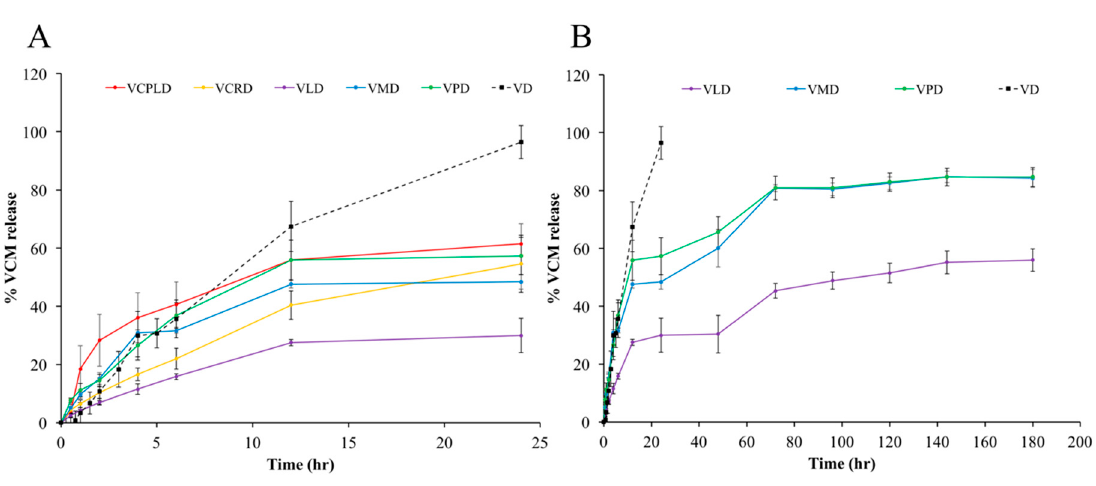
Table 3. Degrees of goodness-of-fit and estimated parameters from curve fittings of the release profiles of vancomycin HCl (VCM)-loaded in situ forming systems in phosphate buffer at pH 7.4 using the membrane-less method.